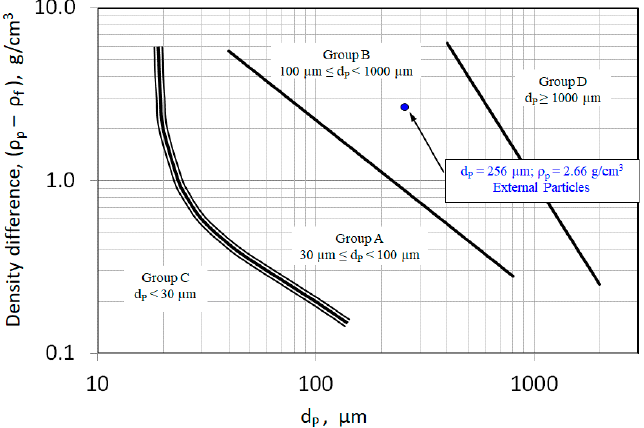
Figure 3. Geldart’s classification-based particle-mixing strategy used for the proposed assisted fluidization technique.